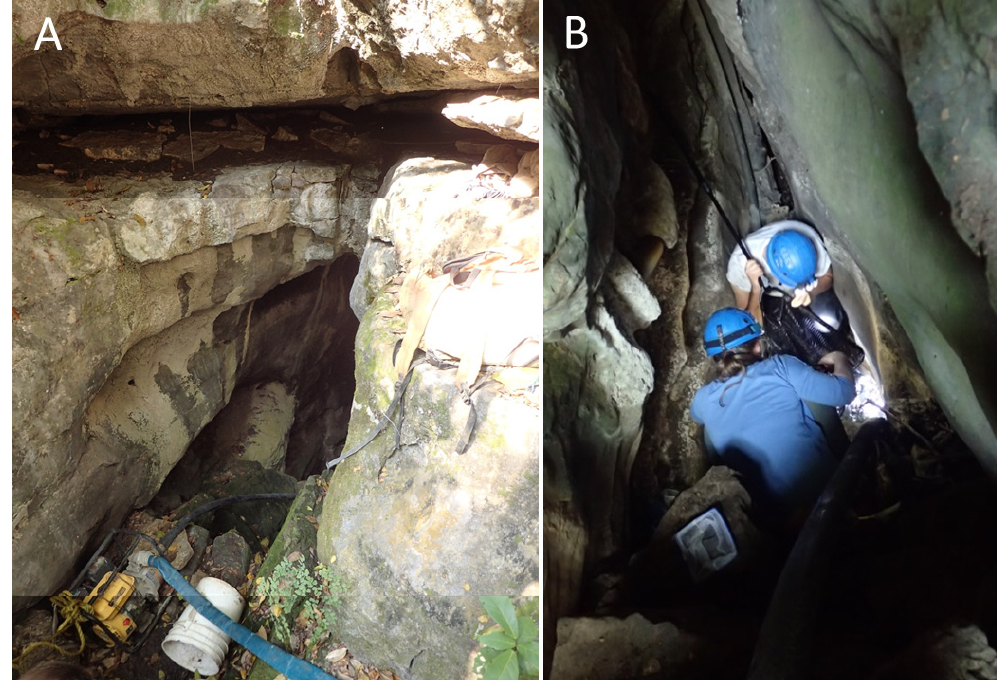
Figure 2. Sótano del Toro. ( A ); Entrance sink descends to a 0.5 m wide by 2.5 m long pool. ( B ); Light reaches this small pool. Locals use a water pump (A) to extract water for the local farm.